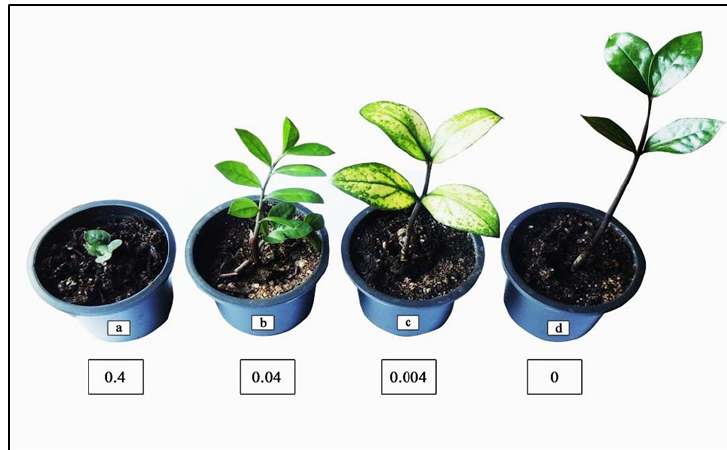
Figure 1: Outcomes after application of different concentrations of colchicine for 24 hours to Zamioculcas zamiifolia leaflets with callus, and growing them for six months in a 70% shaded greenhouse. a) 0.4%, b) 0.04%, c) 0.004% and d) 0% (distilled water control, original